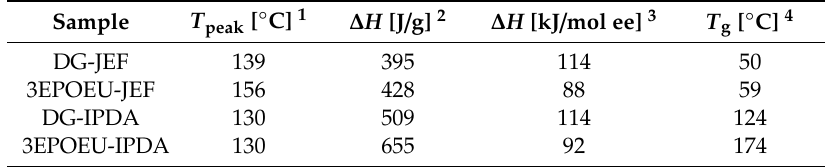
Figure 1. Differential scanning calorimetry (DSC) thermograms corresponding to the dynamic curing at 10 °C/min of the materials studied. Table 2. Calorimetric data of the curing of the formulations studied.